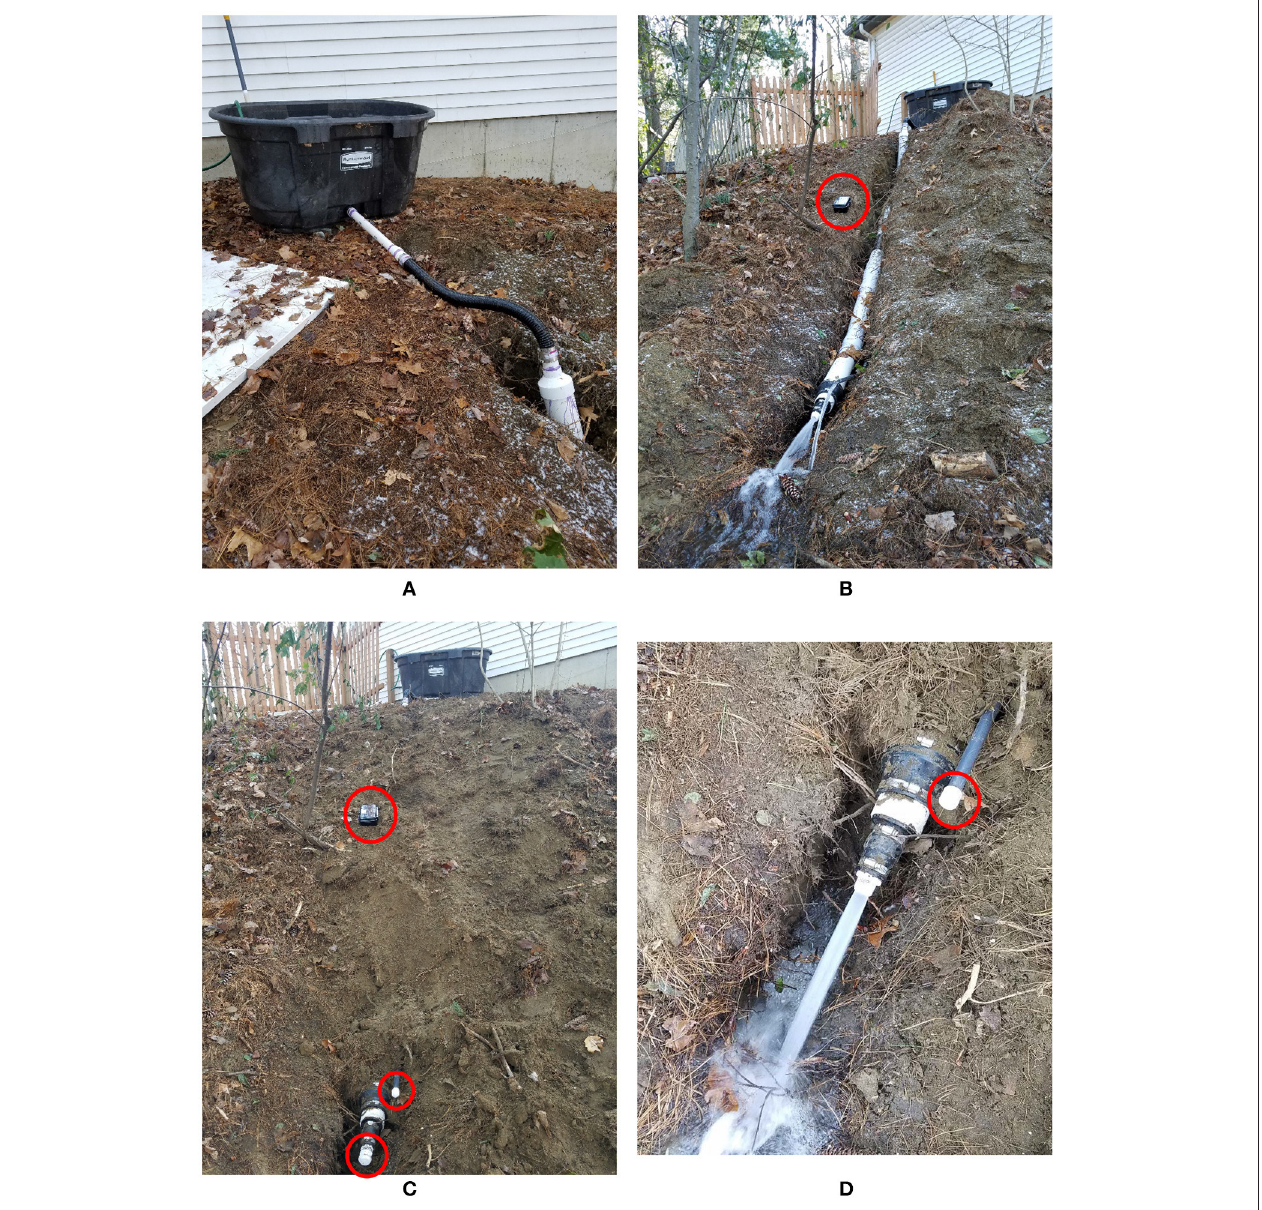
FIGURE 18 | (A) Rain barrel water source for buried pipe containing rotating magnet flow meter. (B) Pipe containing rotating magnet flow meter before burial. Arduino Mega unit with magnetometer and LoRa transmitter is indicated. (C) Pipe after burial. The Arduino Mega unit and the pipe’s two drain outlets are circled in red. (D) Water drains through the larger of the two drain outlets. The smaller drain outlet is circled in red.